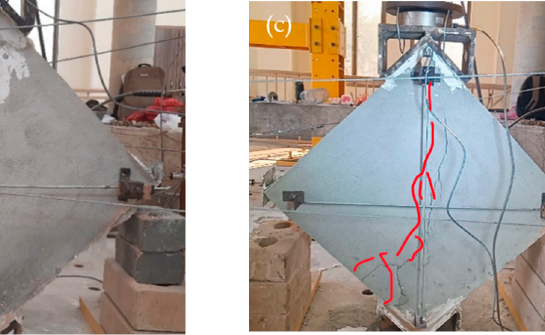
Figure 13. Failure pattern of SFD-reinforced specimens.